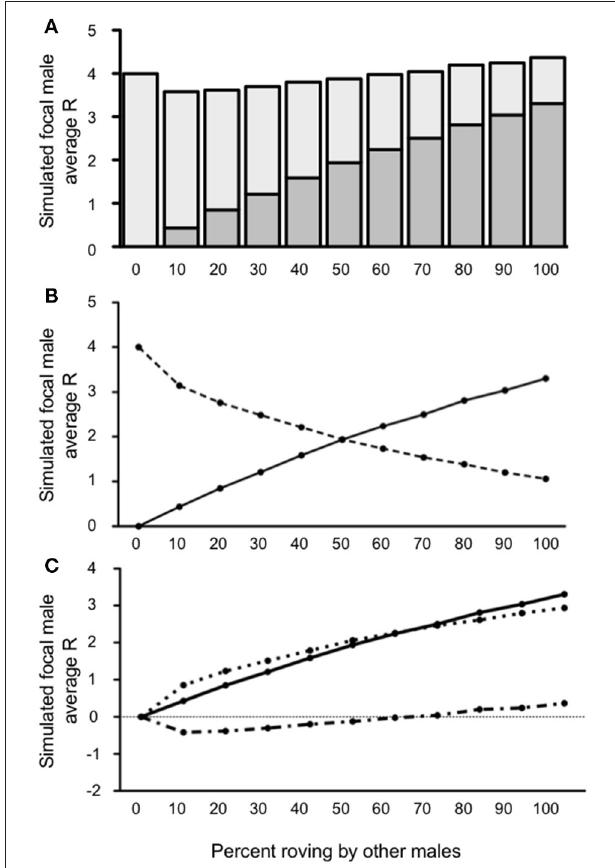
FIGURE 4 | Reproductive success for simulated roving focal male in Condition 2 at pair population 1,000 with 10% wandering. (A) Mean reproductive success (R) obtained by the simulated roving focal male at each percentage of roving in the population, split between R gained via extra-pair copulations (EPC; dark gray) and intra-pair copulations (IPC; light gray). (B) Average R gained via EPCs (solid line) and IPCs (dashed line) by the simulated roving focal male as the percentage of roving in the population increases. (C) Average R gained via EPCs ( E , solid line), average R lost via cuckolding ( C , dotted line), and total change in R ( 1 R, dash-dotted line) for the simulated roving focal male as the percentage of roving in the population